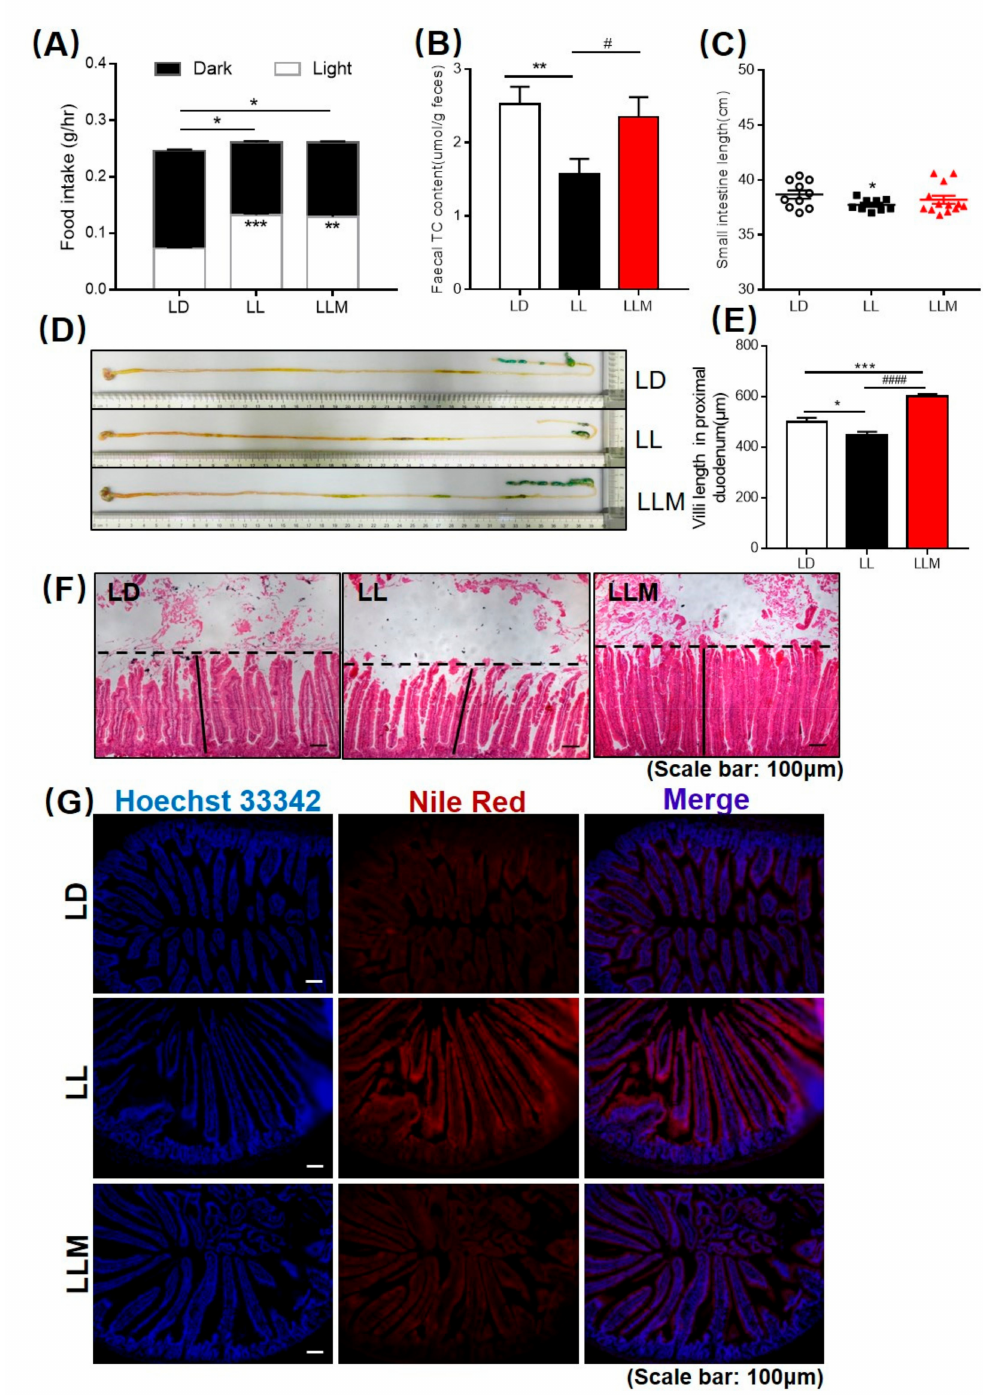
Figure 6. Constant lighting changes the pattern of food intake, and melatonin improves the intestinal morphology of mice. ( A ) Mice under the constant lighting condition ate more food during the diurnal phase than during the nocturnal phase. ( B ) Fecal TC content. ( C ) Small intestine length. ( D ) Representative images of the gastrointestinal system. ( E ) Proximal duodenum villus length. ( F ) H&E staining of duodenum sections (scale: 100 µ m) ( G ) Nile Red staining of jejunum sections (scale: 100 µ m). Values are presented as the mean ± SEM. N = 16–20, * p < 0.05; ** p < 0.01; *** p < 0.001 compared with LD, # p < 0.05; ## p < 0.01; ### p < 0.001 compared with LL by one-way